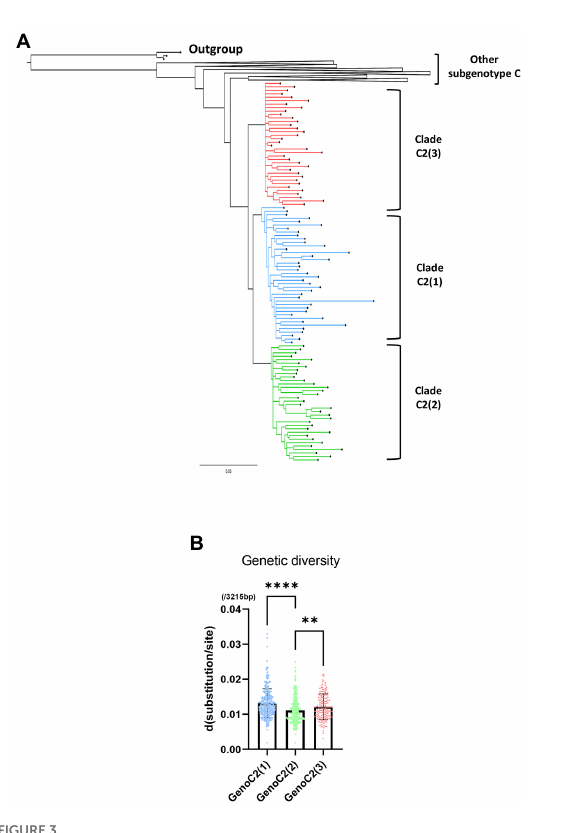
FIGURE 2 The frequency of two signature mutations specific for C2(3), sV184A and xT36P, from Korean chronic HBV infection patients from Konkuk university hospital. (A) A Venn diagram of 131 previously studied RT sequences and 127 HBx sequences generated in this study. (B) A total of 79.5% of Korean HBV C2(3) patients carried the xT36P mutation in HBx, and 65.8% of the patients carried sV184A in HBsAg. (C) A total of 65 DNA sequences of the HBsAg and HBx regions were accessible, and 61.5% showed both C2(3) signature